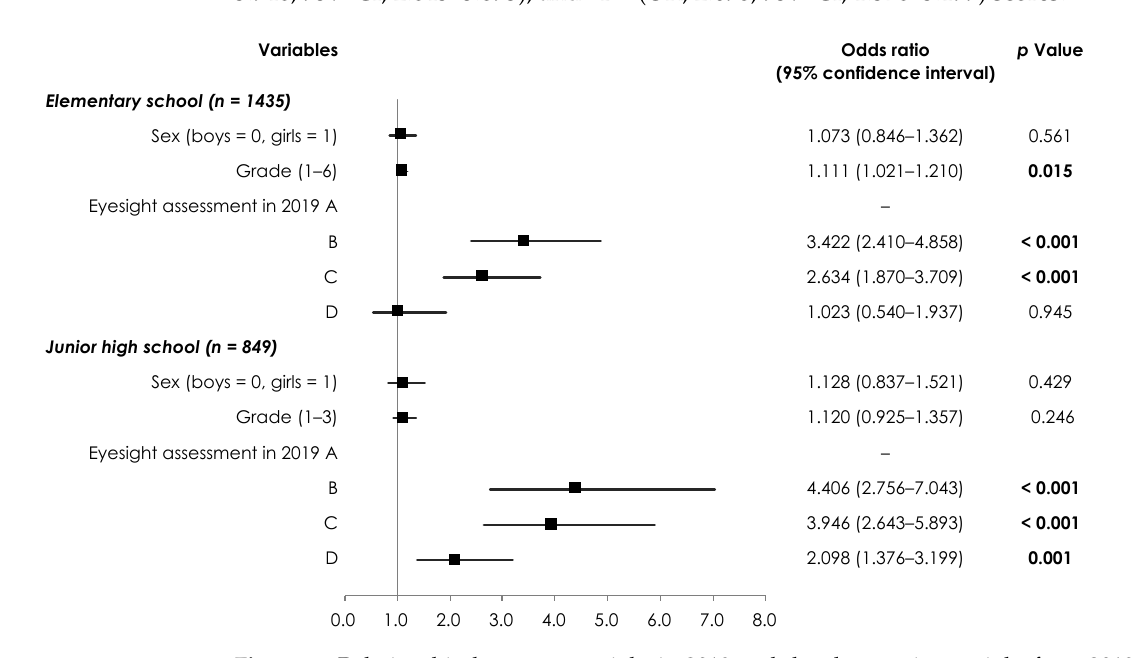
Figure 1. Binomial logistic regression analysis of the relationship between the survey year and poor eyesight. The dependent vari- able was eyesight score (0 = A, 1 = B–E), and the independent variable was the survey year. Measures of associations are displayed as odds ratios (black squares) and 95% confidence intervals (horizontal spikes). Significant p values are shown in bold.